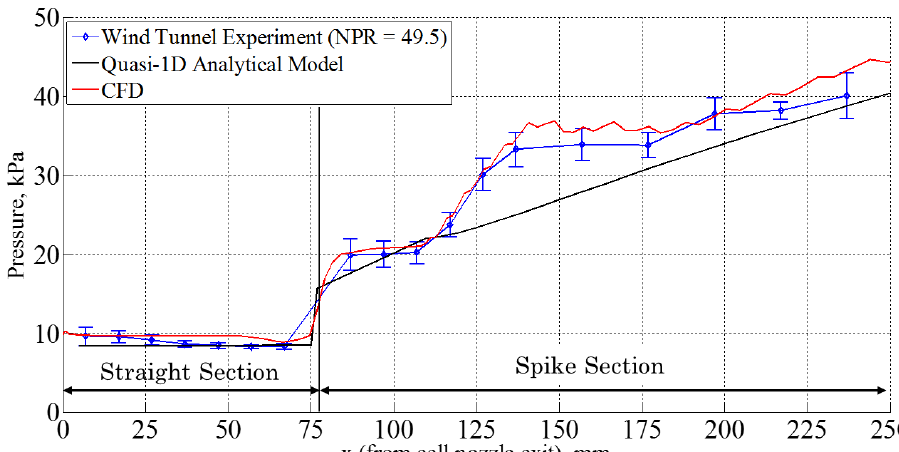
Figure 8. Comparison of spike wall pressure distribution among the experiment, analytical model, and computational fluid dynamics (CFD). The nozzle pressure ratio (NPR) was 49.5 and the external flow Mach number was 2.0.